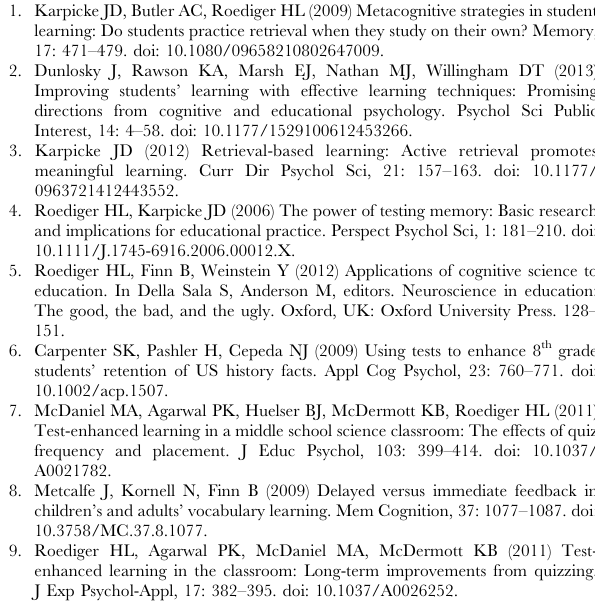
Table S2 Distributions of each factsheet across the four cells of the experiment (upper part of table), and across year groups (lower part of table), for Experiments 1 and 2. Table S3 Performance in the initial learning phase (percentage of all potential facts written on notes) for Experiment 1 (upper part of table) and Experiment 2 (lower part), broken down by condition. Table S4 Numbers of participants in each year group in each cell of Experiments 1 and 2, only including participants who contributed data at all testing points. Table S5 Results of the generalized linear mixed model for Experiment 1. Table S6 Results of the generalized linear mixed model for Experiment